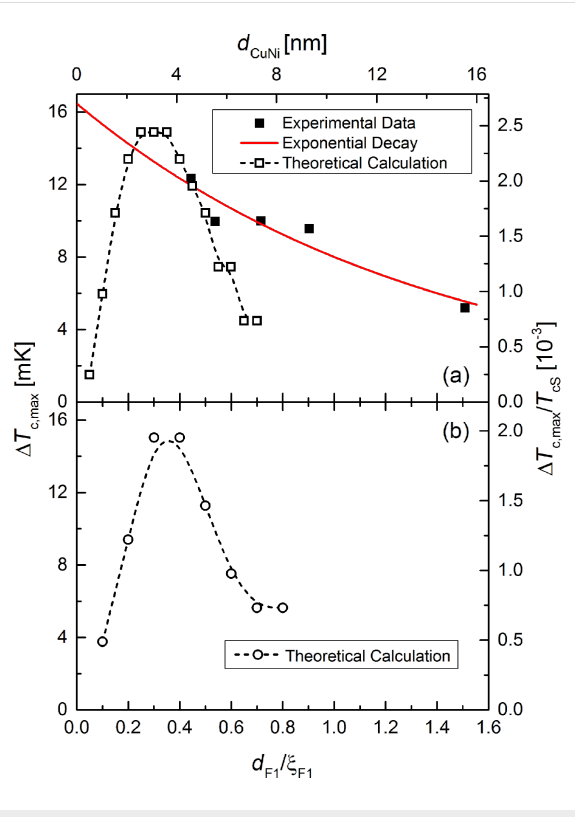
Figure 9: Maximum reduction of the transition temperature, Δ T c,max by the triplet SSV effect at crossed configuration of the magnetic moments of the two ferromagnetic layers as a function of the thick- ness of the Cu 41 Ni 59 layer. While the solid squares in (a) show experi- mental data, the open squares and circles in (a) and (b) show theoreti- cal predictions as derived from the theory of Fominov and co-workers [15]. The theoretical data is plotted both in absolute and normalized (with respect to T cS ) units. In (a), we assumed T cS = 6.1 K, in (b) we used T cS = 7.7 K, which is the critical temperature of a free standing Nb film of 12 nm thickness. The red line in (a) is a fit to an exponential decay according to Equation 3, using l F1 = 7.1 nm and Δ T c,max (0.6 nm) = 16.5 mK. Moreover, we used ξ F1 = 10.3 nm for the magnetic coherence length in the F 1 layer (Cu 41 Ni 59 layer) to plot the data as a function of the reduced thickness d F1 / ξ F1 . For a